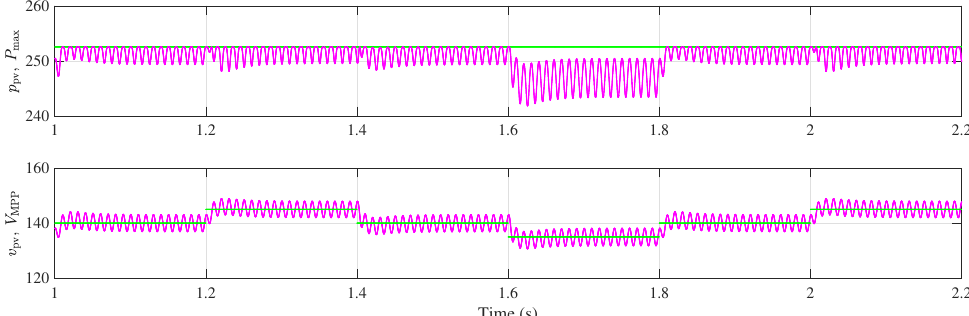
Figure 5. Time-domain waveforms of the sampled extracted power p pv for S = 200 W/m 2 in steady-state operation. V M = 3.2 V.